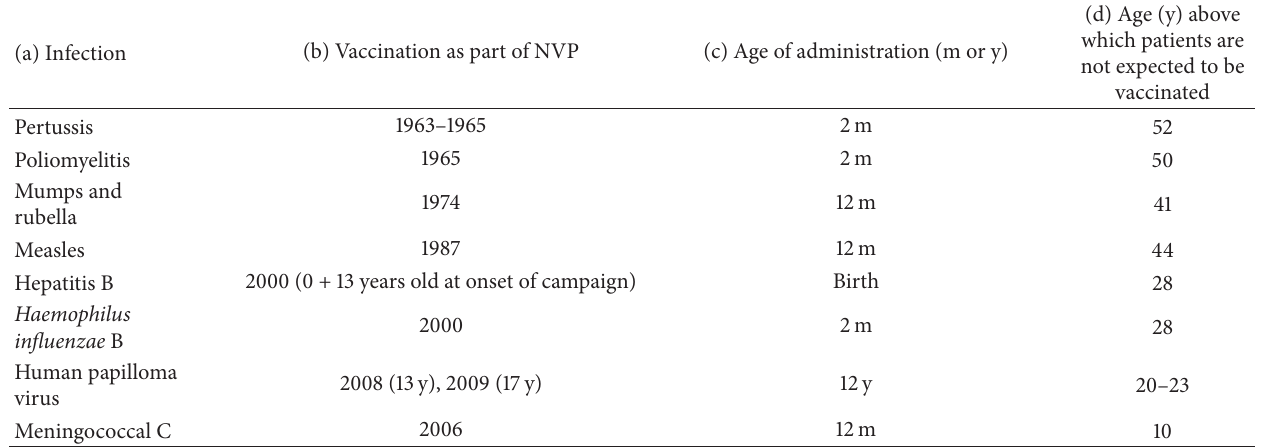
Table 1: (a) Vaccination, (b) vaccination as part of NVP, (c) ages at which vaccination is administered, and (d) age above which patients are not expected to have been vaccinated in Portugal up to December 2015; m: months; y: years.